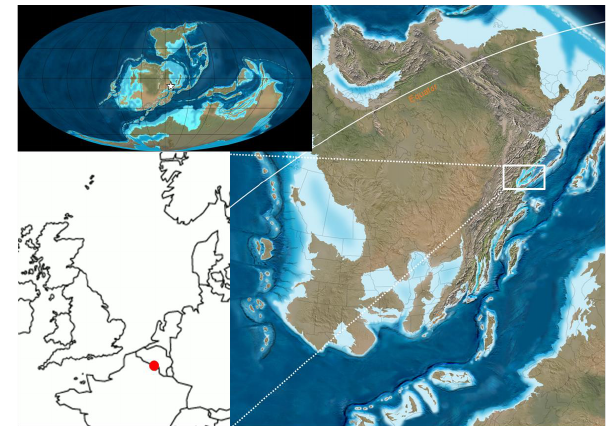
Fig. 1. Mid-Devonian paleogeography (after Ron Blakey, Northern Figure 1. Mid-Devonian paleogeography (after Ron Blakey, Northern Arizona University 4 Arizona University Geology) and present-day situation of the “La Geology) and present-day situation of the “La Couvinoise” section. 5 Couvinoise”